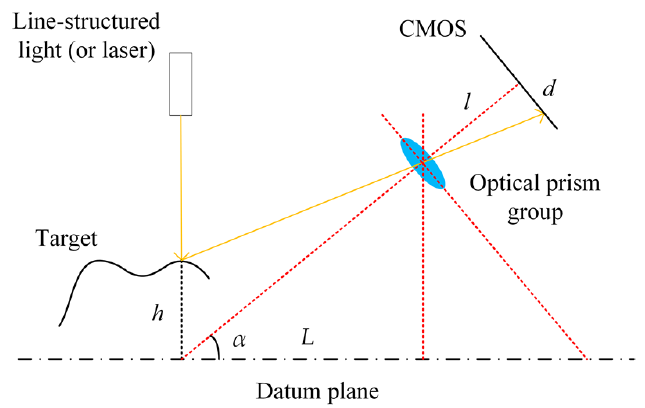
Figure 5. Schematic diagram of the laser triangulation measurement. The original point is the intersection of the laser and the lens normal when the laser is incident perpendicular to the reference plane. The plane that passes through this point, which is also perpendicular to the laser line, is taken as the reference plane. The height h of the measured point of the object can be expressed as: